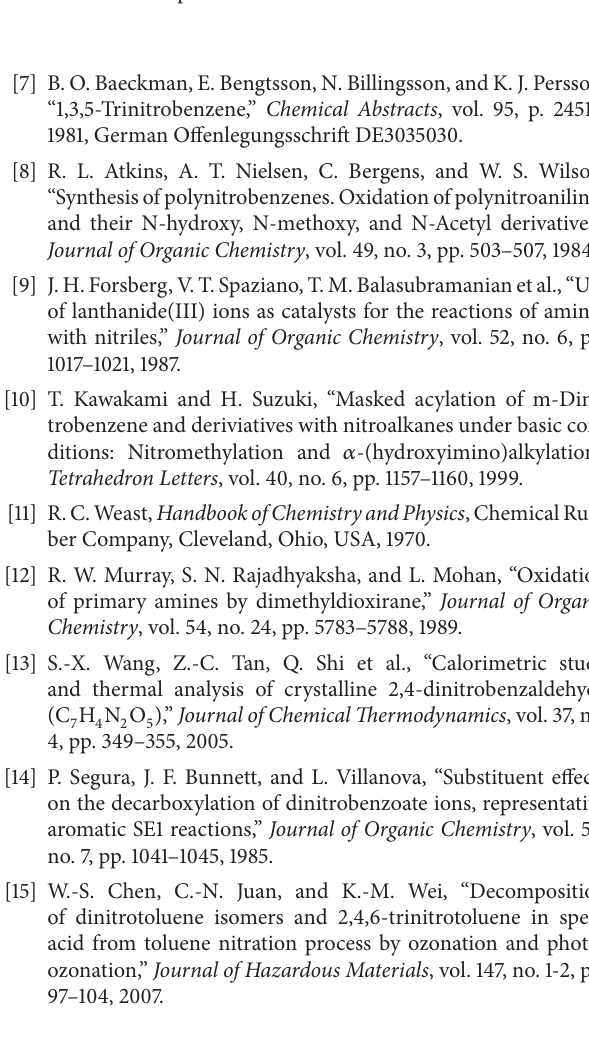
Figure 2: Plausible mechanism for the formation of